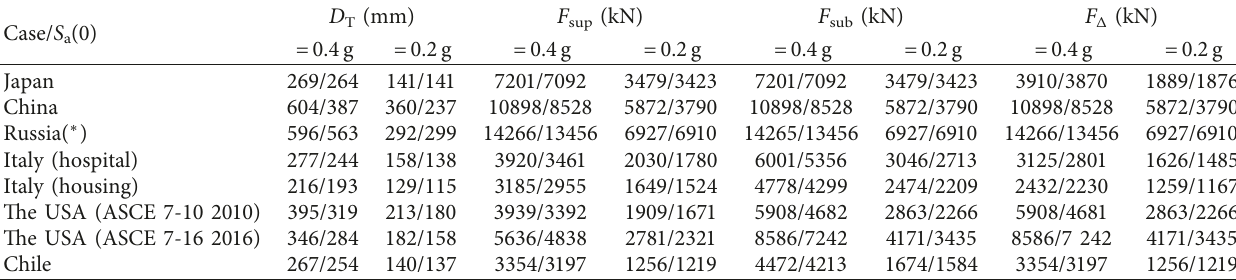
Table 19: Design parameters for static/time-history analysis of the analyzed